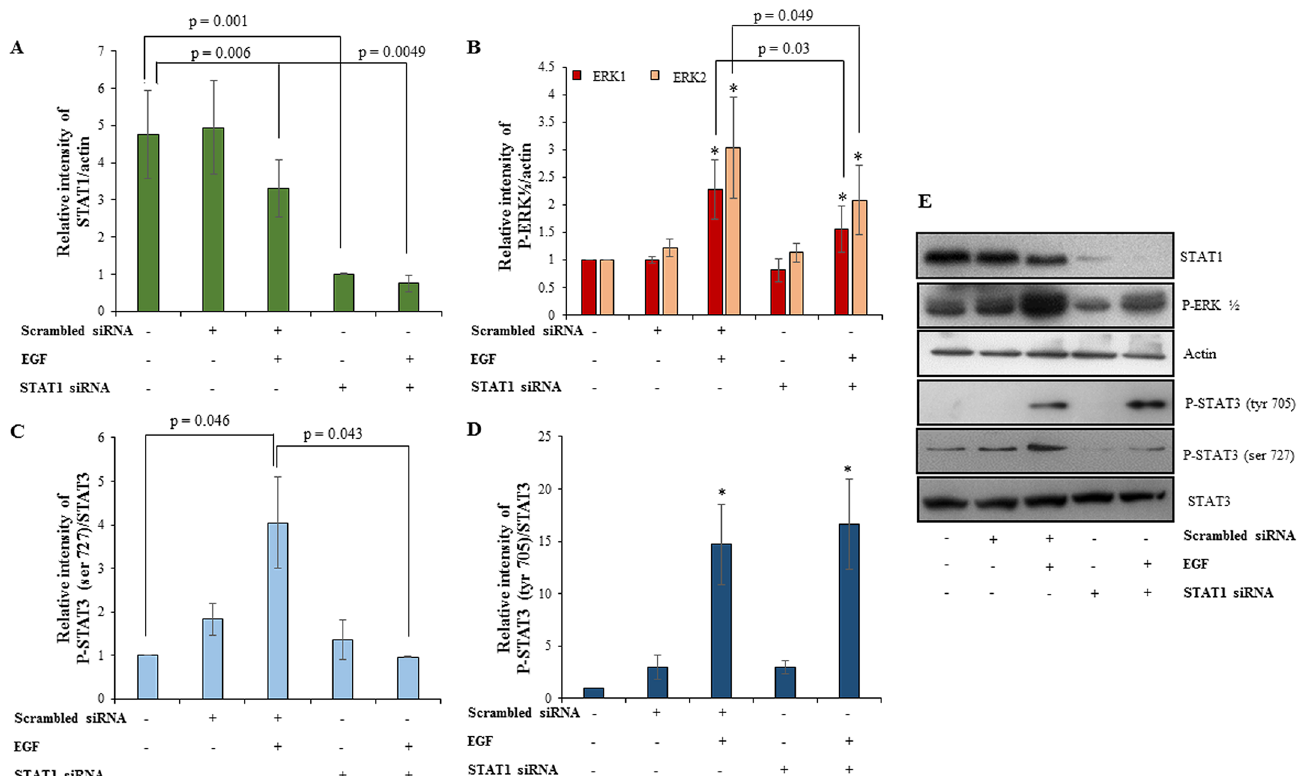
Fig 8. Effect of STAT1 silencing on phosphorylation of ERK ½ and STAT3 in presence/absence of EGF treatment. STAT1 was silencedin HTR-8/SVneo cells using siRNA as describedin Materials and Methods . The na ï vecells, scrambledsiRNA and STAT1 siRNA transfected cells were treated with EGF (10 ng/ml) for 60 min. Panel A shows densitometric plot of total STAT1 levels as comparedto actin in presenceor absenceof EGF treatment to confirm silencingof STAT1 by Western blot. Panels B, C and D represent densitometric profilesof phosphorylated ERK ½ as comparedto actin, phosphorylated STAT3 at ser727 and tyr 705 as comparedto total STAT3 respectivelyin na ï vecells, scrambledand STAT1 siRNA treated cells in presence or absenceof EGF. Panel F show representativeblots from one of the three independentexperiments. The data is shown as mean ± SEM of three independentexperiments and band intensitieswere normalized with respect to loadingcontrol duringdensitometric analysis. * p < 0.05 with respect to untreatedcontrol cells.